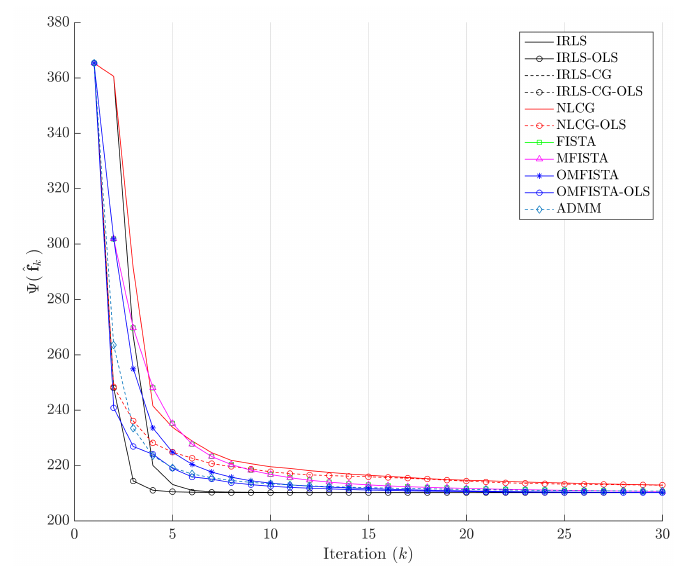
Figure 14. Cost function Ψ ( ˆ f k ) versus iteration number k —Synthetic dataset.